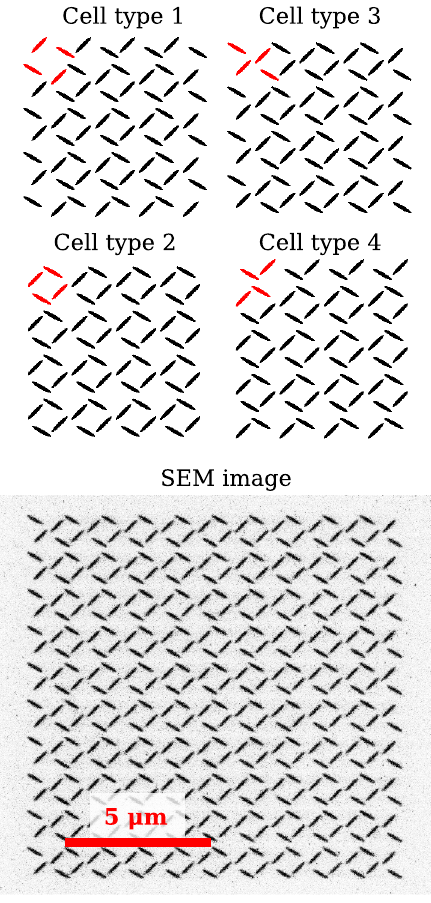
FIG. 1. Top figures: Illustration of the four different crystal types that were designed for the diffraction experiment. The unit- cell contents for each type are indicated in red. The full-size crystals used in the experiment had randomly chosen edge lengths ranging from 5 to 12 unit cells, with the two dimensions varying independently of each other (allowing for rectangular crystals). Bottom figure: SEM image of an actual sample, with distance scale indicated in